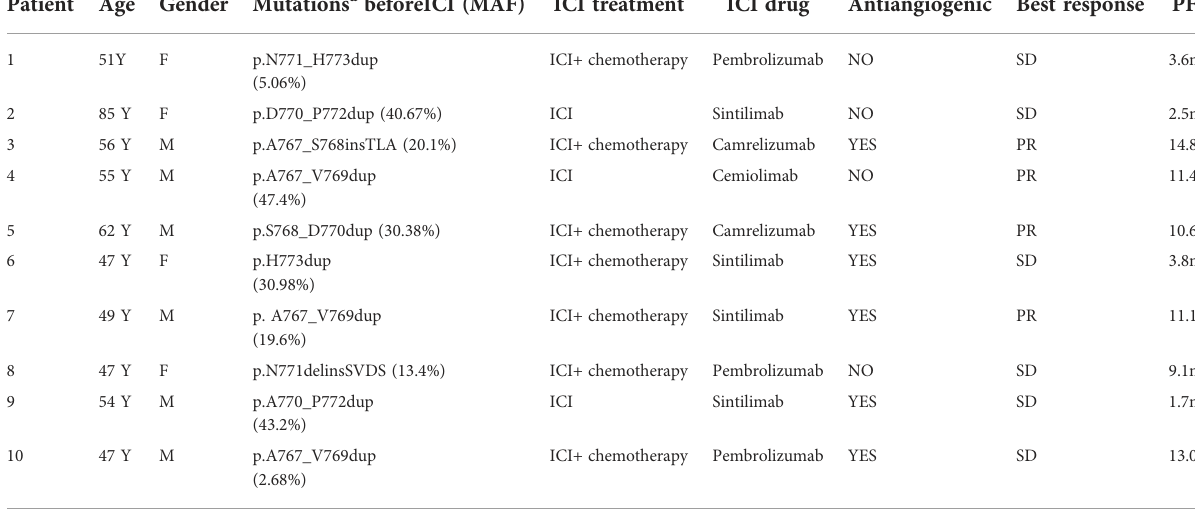
TABLE 2 Mutation characteristics and outcome of immunotherapy as fi rst-line treatment. Patient Age Gender Mutations a beforeICI